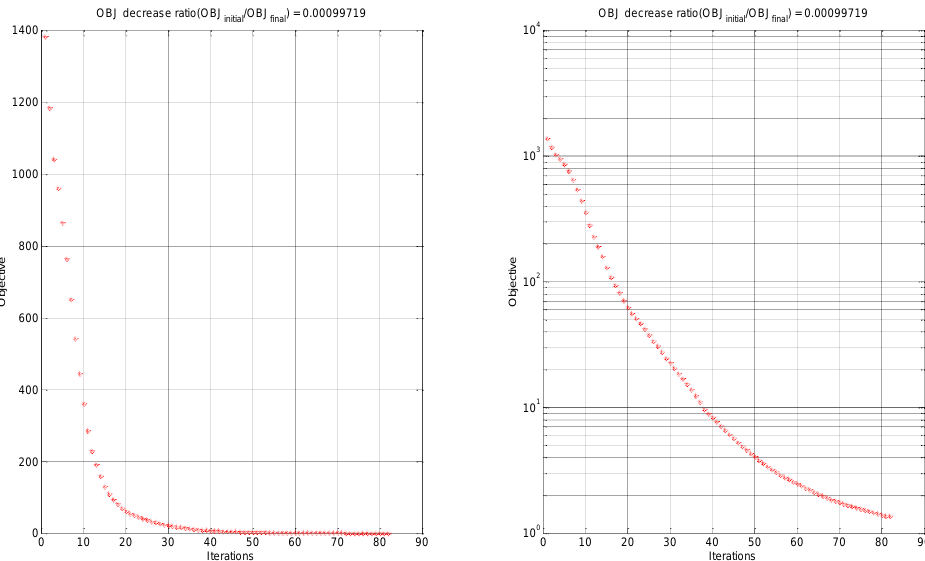
Figure 8—History of objective (normal and semilog